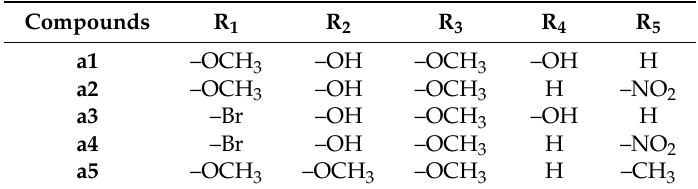
Table 1. Structure of the compounds a1 – 5 .